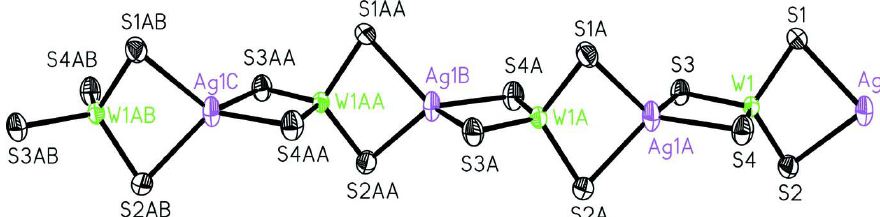
The molecular structure of a portion of the anionic chain in the title compound, with atom labels and 30% probability displacement ellipsoids. (symmetry codes: A x , - y + 1/2, z + 1/2; AA and B x , y , z + 1; AB and C x , - y + 1/2, z +